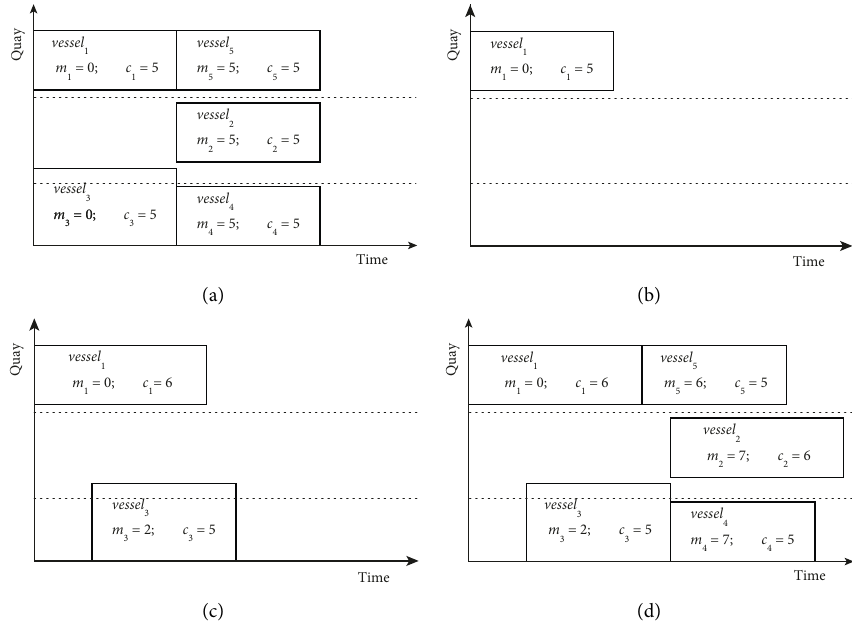
Figure 2: Evolution of baseline schedule under uncertainty conditions. (a) Baseline schedule. Solution makespan � 10. (b) Current schedule at t � 0. Unchanged with respect to the baseline schedule. (c) Current schedule at t � 2 where the handling time of vessel 1 is lengthened one time unit and vessel 3 is delayed two time units. (d) Current schedule at t � 13 where the service start time of vessels 2, 4, and 5 has been delayed due to events occurred at t � 2. Solution makespan �